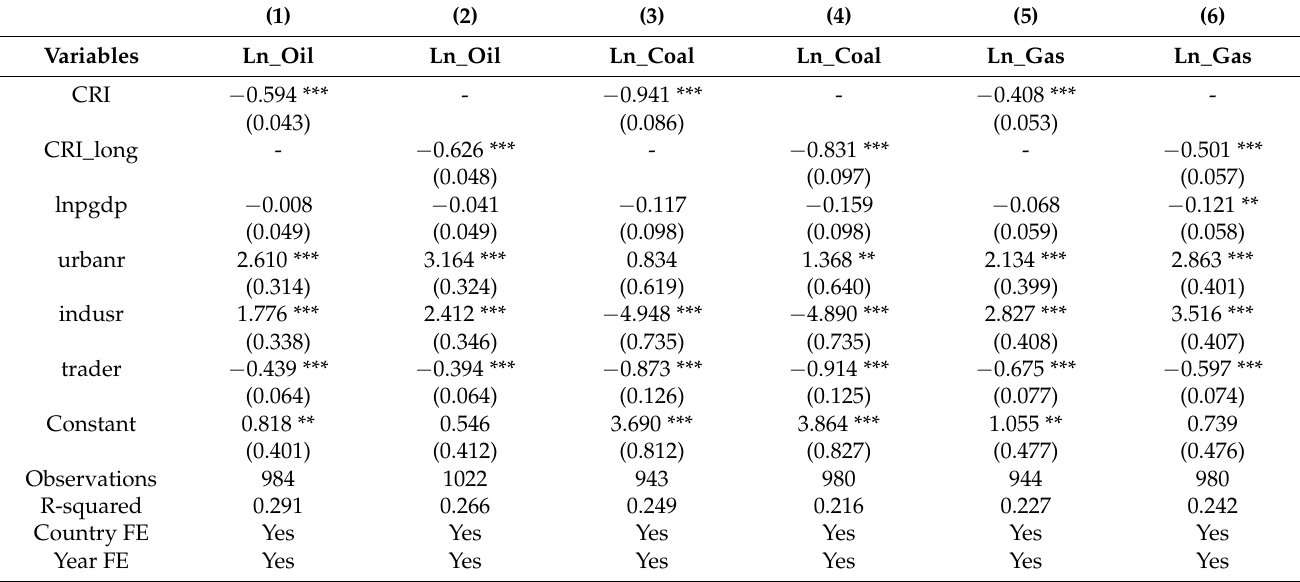
Table 5. Estimation results of the effect of climate risk on fossil energy